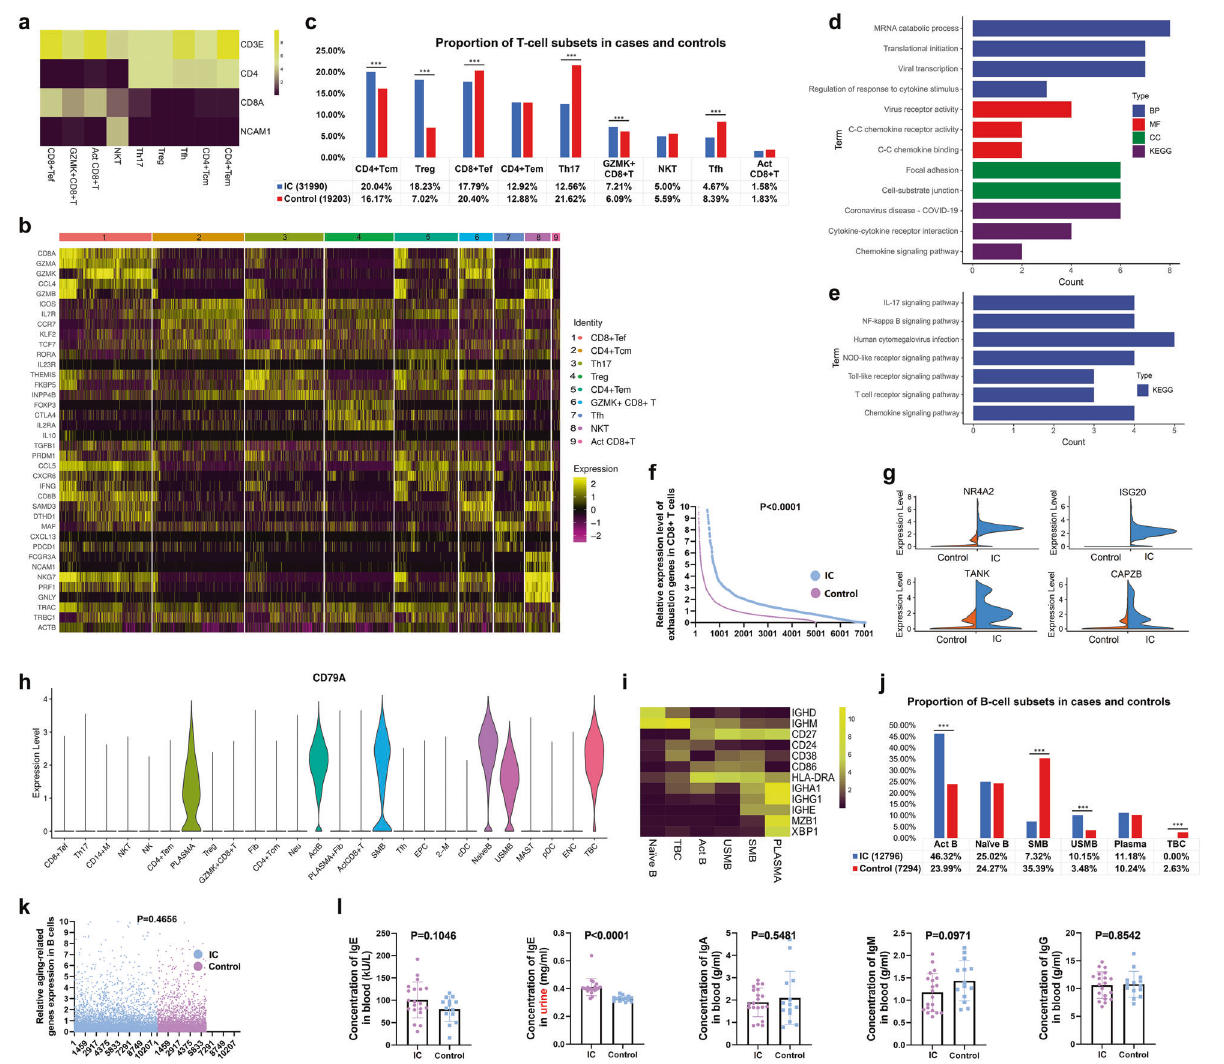
Fig. 2 Focused analysis of T and B cells. a The expression of CD3E, CD4, CD8A, and NCAM1 across the clusters. b Heatmap showing the expression of selected marker genes across the T cell clusters. c The changes of proportion in T cell subsets between the two groups (*** P < 0.001). d Bar chart showing the signi fi cant GO and KEGG terms of Tregs in the IC group compared with the control group. e Signi fi cant KEGG terms of Th17 in the IC group compared with the control group. f The relative expression level of all exhausted genes in CD8 + T cells between the IC and control groups. g The expression level of representative exhausted markers in the two groups. h Violin plot showing the expression of B cell marker gene (CD79A) across the clusters. i Heatmap showing the expression of selected marker genes across the B cell clusters. j The changes of proportion in B cell subsets between the two groups (*** P < 0.001). k The relative expression level of aging-related genes in B cells between the IC and control groups. l The expression leve l of immunoglobulins including IgA, IgM, IgG, and IgE in plasma or urine of IC patients and controls (mean ± standard deviation, Mann – Whitney U -test, two-tailed; IC, n = 20, control, n = 14). IC interstitial cystitis, CD8 + Tef CD8 + effector T cell, CD4 + Tcm central memory CD4 + T cell, Treg regulatory T cell, CD4 + Tem effector memory CD4 + T cell, Tfh